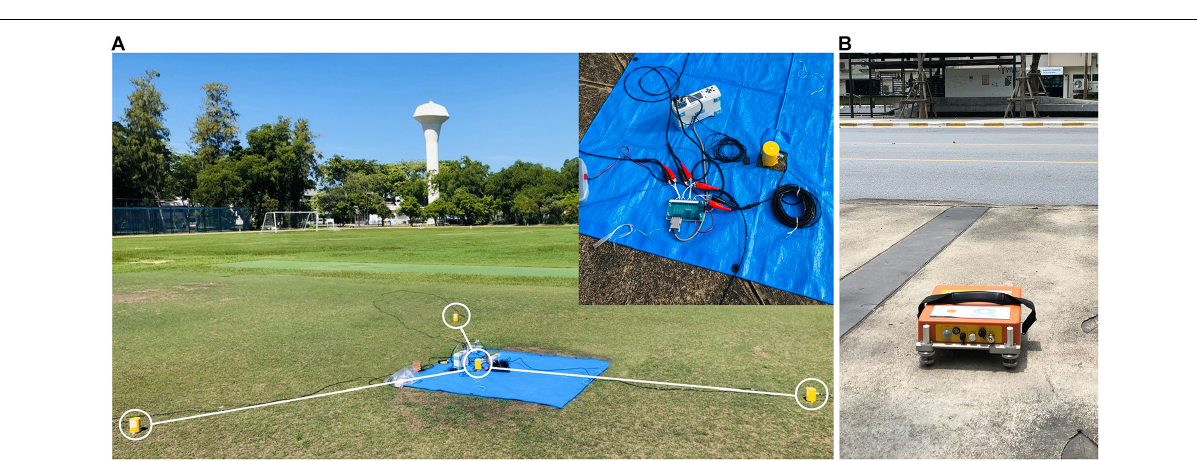
carried out twice by two instruments simultaneously. Figure